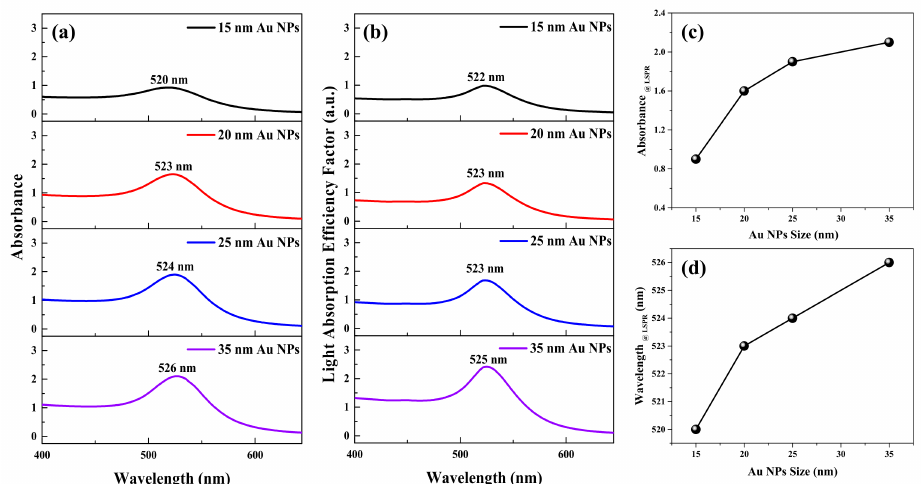
Figure 2. UV-Vis absorption spectra result by ( a ) experiment and ( b ) simulation by NANODDSCAT+. ( c ) Change in absorbance and ( d ) wavelength at LSPR as a function of particle size. The absorption band for different sizes of Au NPs from both experimental and simulation results is consistent, and the trajectory of absorbance and the wavelength at LSPR as a function of size follows the Mie